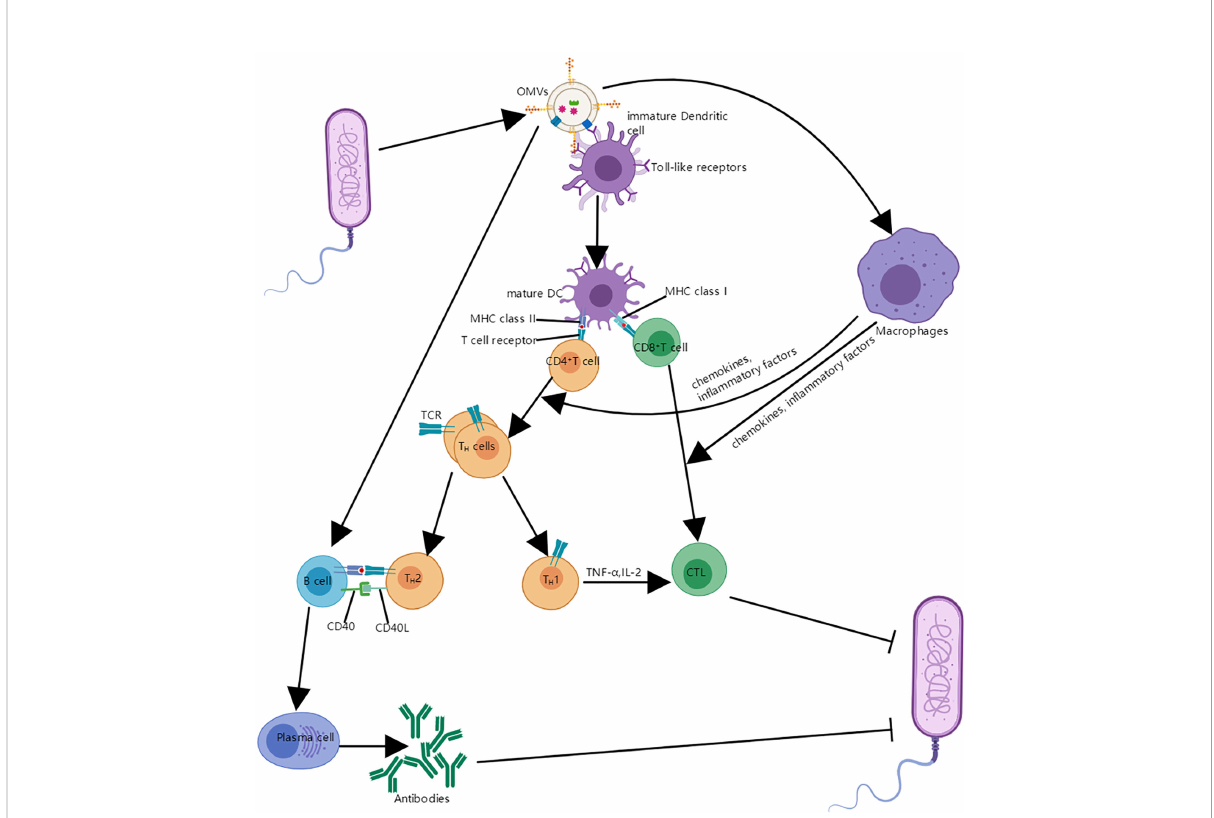
FIGURE 5 The interaction between OMVs and immune system. OMVs interact with immature DCS and are internalized. Mature DCs can process antigens and then present antigen epitopes on their surface in the form of the MHC complex; the modi fi ed antigen is recognized by the T cell antigen receptor on the CD4 T cell and CD8 T cell surface, which leads to the helper T cells and cytotoxic T lymphocyte (CTL). In addition, OMVs can also interact with B cells and proliferate into plasma cells and produce antibodies with the assistance of T H 2 cells; OMVs can also be absorbed by macrophages, which makes expression of cytokines and chemokines increase and it is helpful for the proliferation and differentiation of T